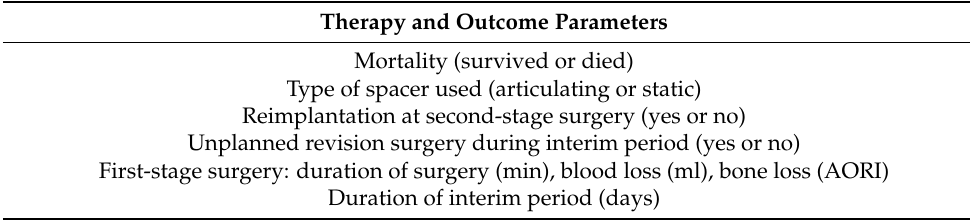
Table 2. Therapy and outcome parameters examined in this